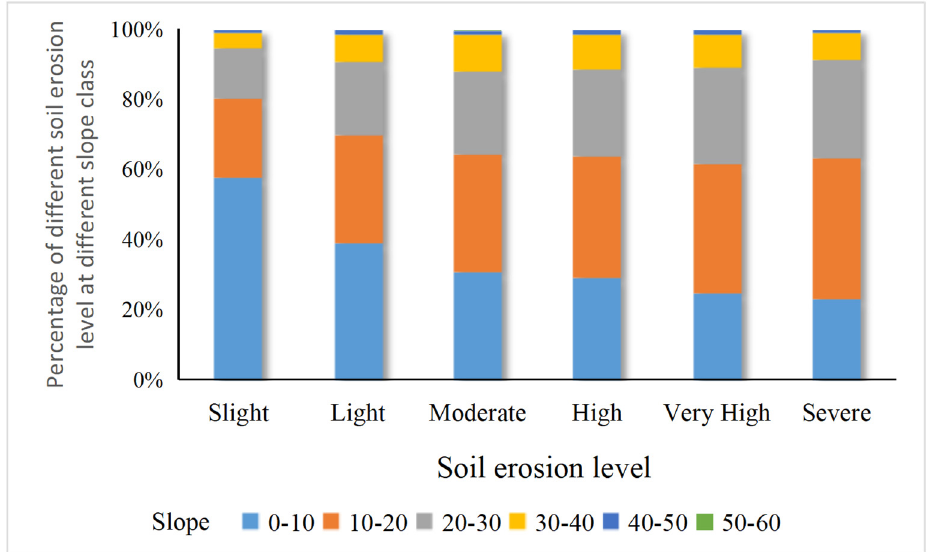
Figure 10. Percentage of soil erosion area in different slope classes in western Hubei Province from 2000–2020.